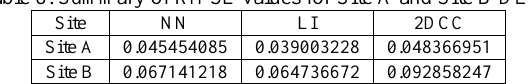
Table 8. Summary of RMSE values for Site A and Site B